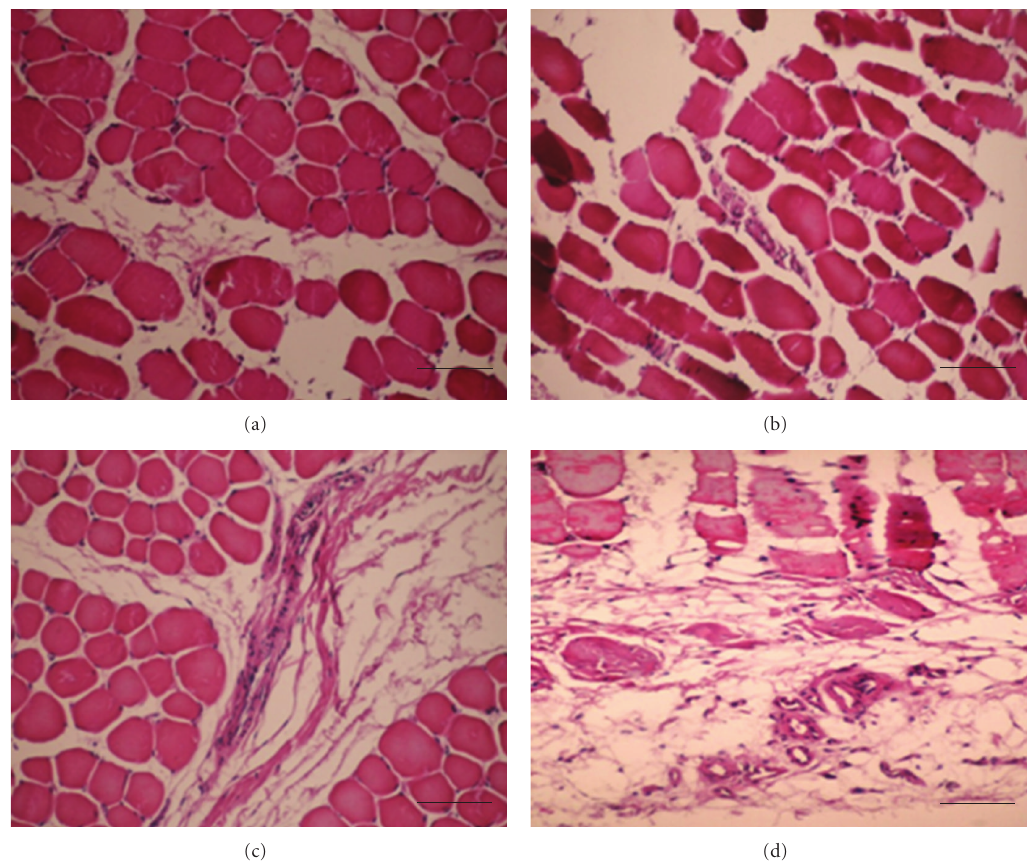
Figure 4: Hematoxylin-eosin analysis for revascularization in the muscles of the ischemic hindlimb 4 weeks after implantation. (a) No treatment; (b) bFGF; (c) CM; (d) bFGF-CM (bar = 50 μ m).